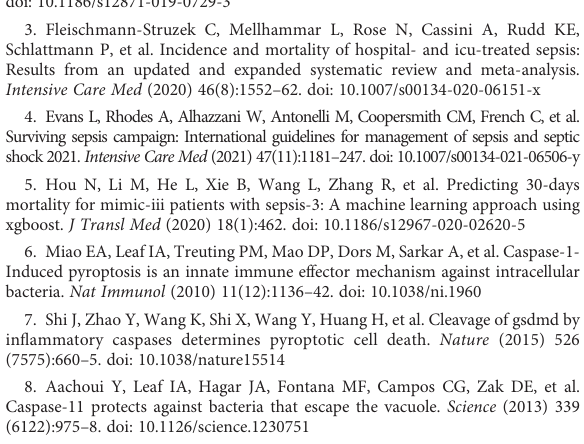
SUPPLEMENTARY FIGURE 1 Consensus clustering analysis based on pyroptosis-related DEGs. (A) Consensus empirical CDF. (B) Delta area. SUPPLEMENTARY FIGURE 2 Univariate and multivariate cox regression of the prognostic predictors. (A) In the validation cohort. (B) In the test